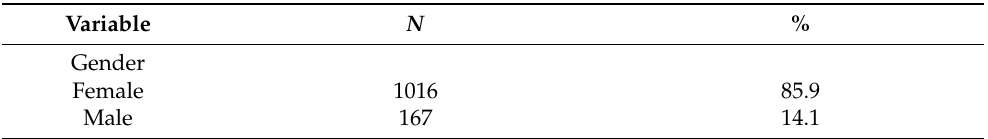
Table 1. Participants’